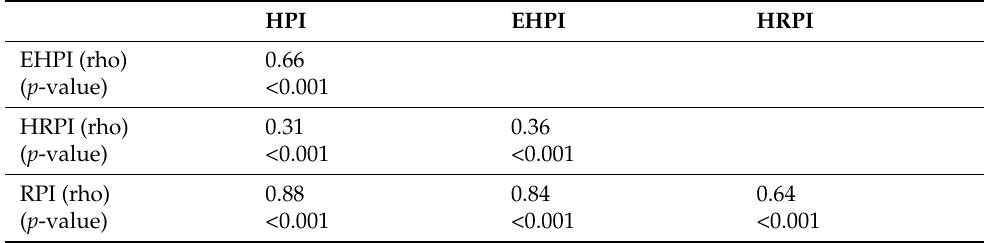
Table 4. Statistical correlations among the perception